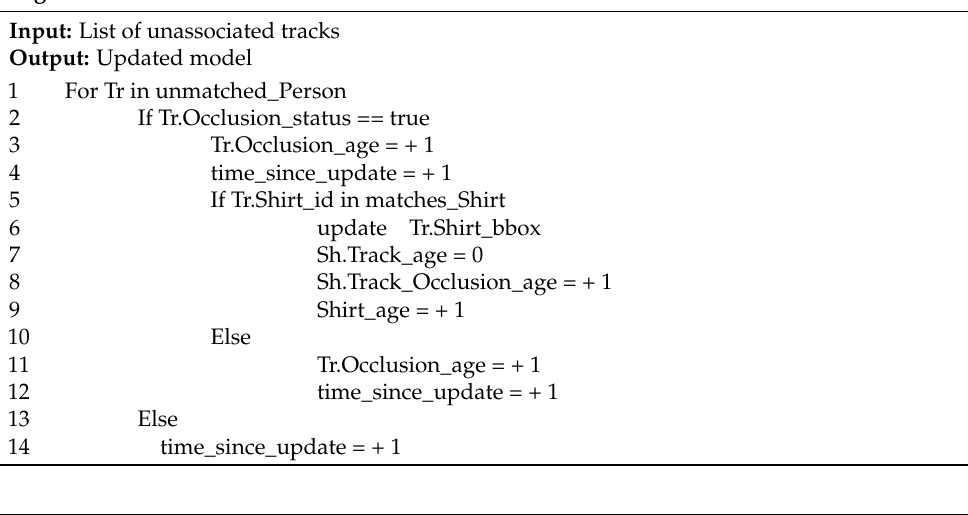
Algorithm 3 Unassociated detections